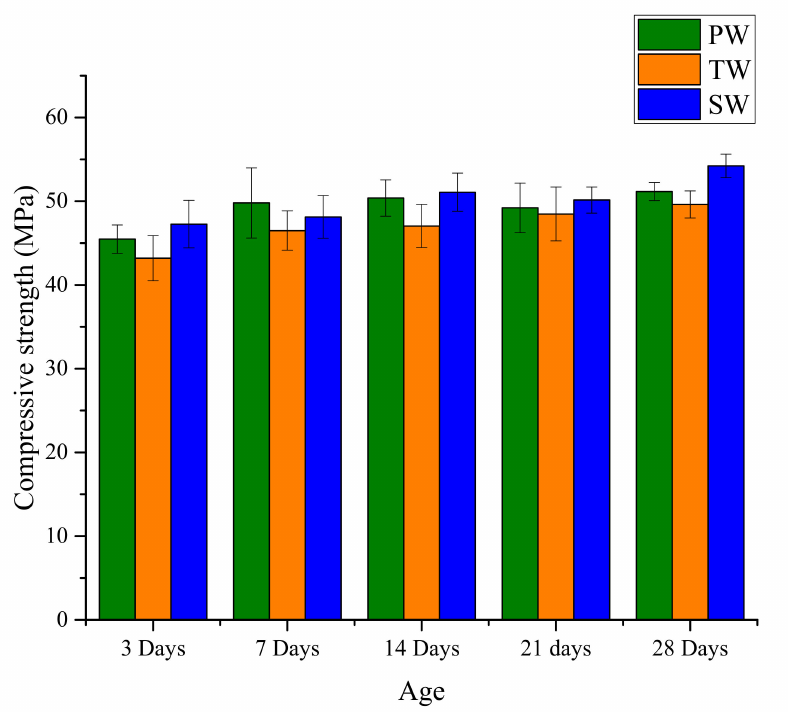
Figure 2. Compressive strength development of alkali-activated materials (AAM) produced with di ff erent types of